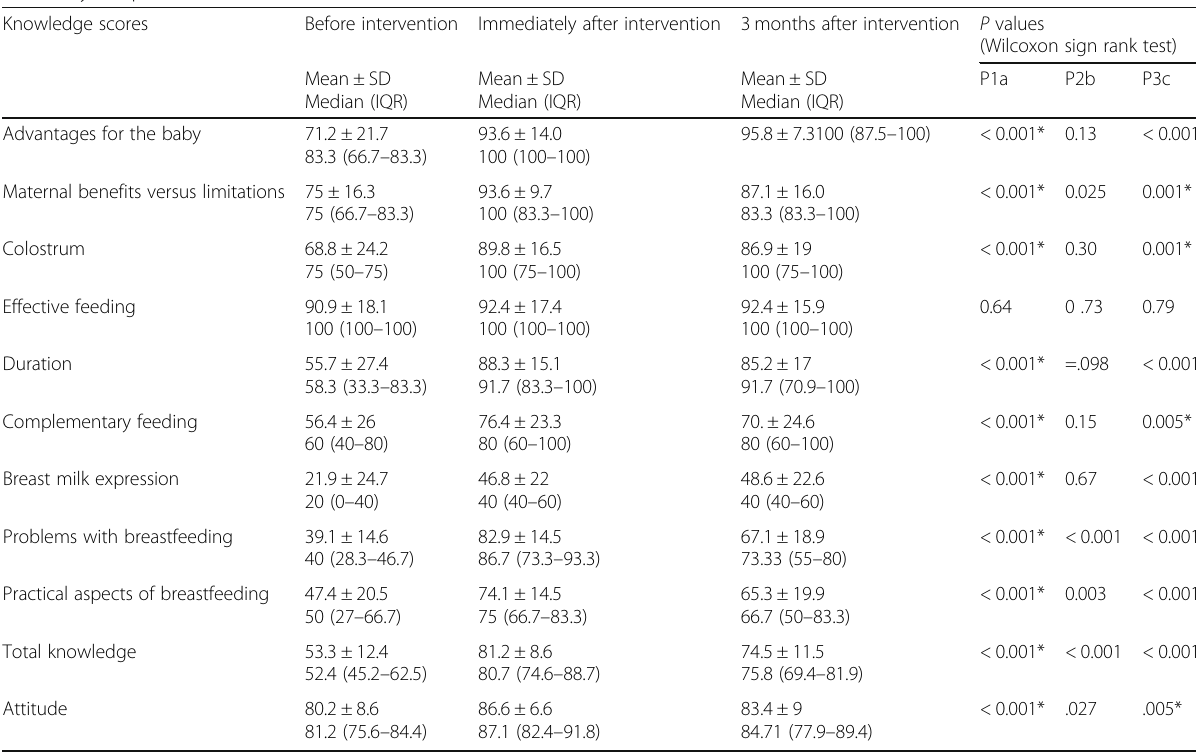
Table 3 Interns ’ ( n = 44) knowledge and attitude percent scores before and after the educational breastfeeding intervention at Cairo University Hospital, 2017 – 2018